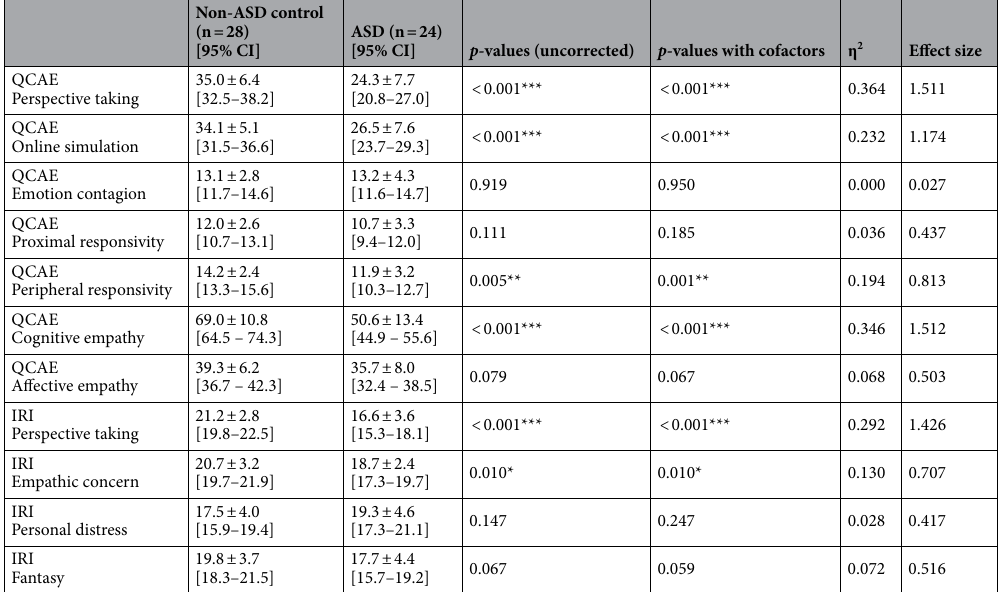
Table 2. Empathy data on the QCAE and IRI. Data are mean ± SD. The number in the bracket is 95% confidence intervals (CI). η 2 semi-partial eta-squared. Effect size represents a sample-based estimate of the quality, QCAE Questionnaire of Cognitive and Affective Empathy, IRI Interpersonal Reactivity Index. * p < 0.05,** p < 0.01,*** p < 0.001. Uncorrected p -values are determined by MANOVA followed by t -tests. Corrected p -values were obtained by a subsequent ANCOVA treating the BDI ad full-scale IQ scores as